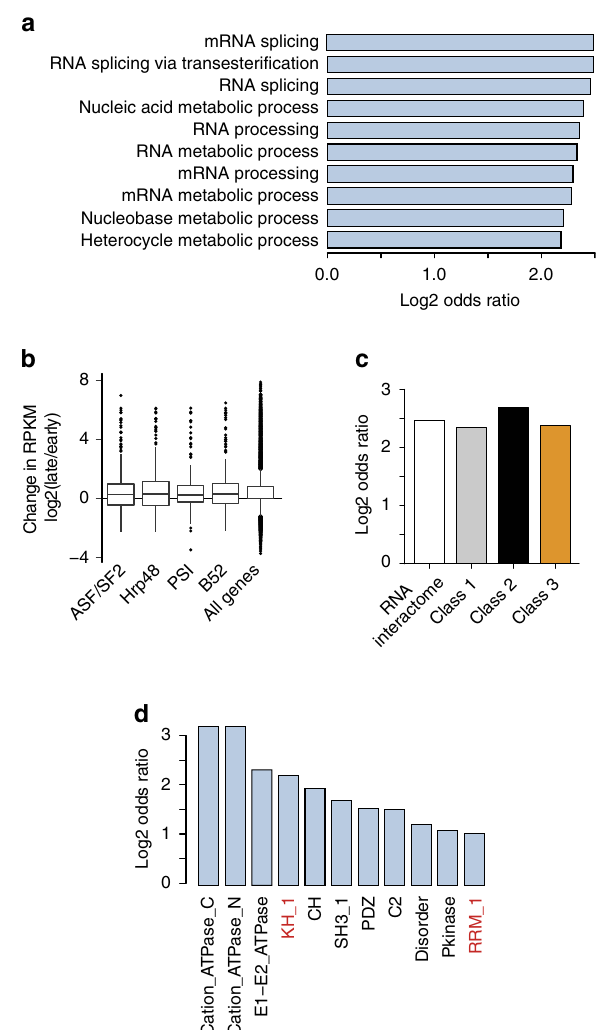
Figure 5 | Possible explanations for dynamic behaviour of some of the RBPs during the MZT. ( a ) Ten most enriched GO terms related to biological process among the class 3 RBPs and RBP candidates (‘dynamic binders’). ( b ) Log2 change in expression levels (RPKM) of putative transcript targets of four splicing factors and all genes. Splicing factors’ targets are identified as transcripts whose abundance is significantly affected (| z -score| 4 2) upon depletion of a splicing factor 33 . Comparison of changes in expression of all genes and splicing factor targets using the Student t -test resulted in the following P values: ASF/SF2–0.6698; Hrp48–0.1532; PSI—0.5239; B52–0.1847. ( c ) Enrichment of alternatively spliced mRNAs in the whole RNA interactome and in the three dynamic classes. Odds ratios are presented. ( d ) Pfam domains enriched among exons that are differentially used between 0–1h and 4.5–5.5h embryos Known RBDs are indicated in